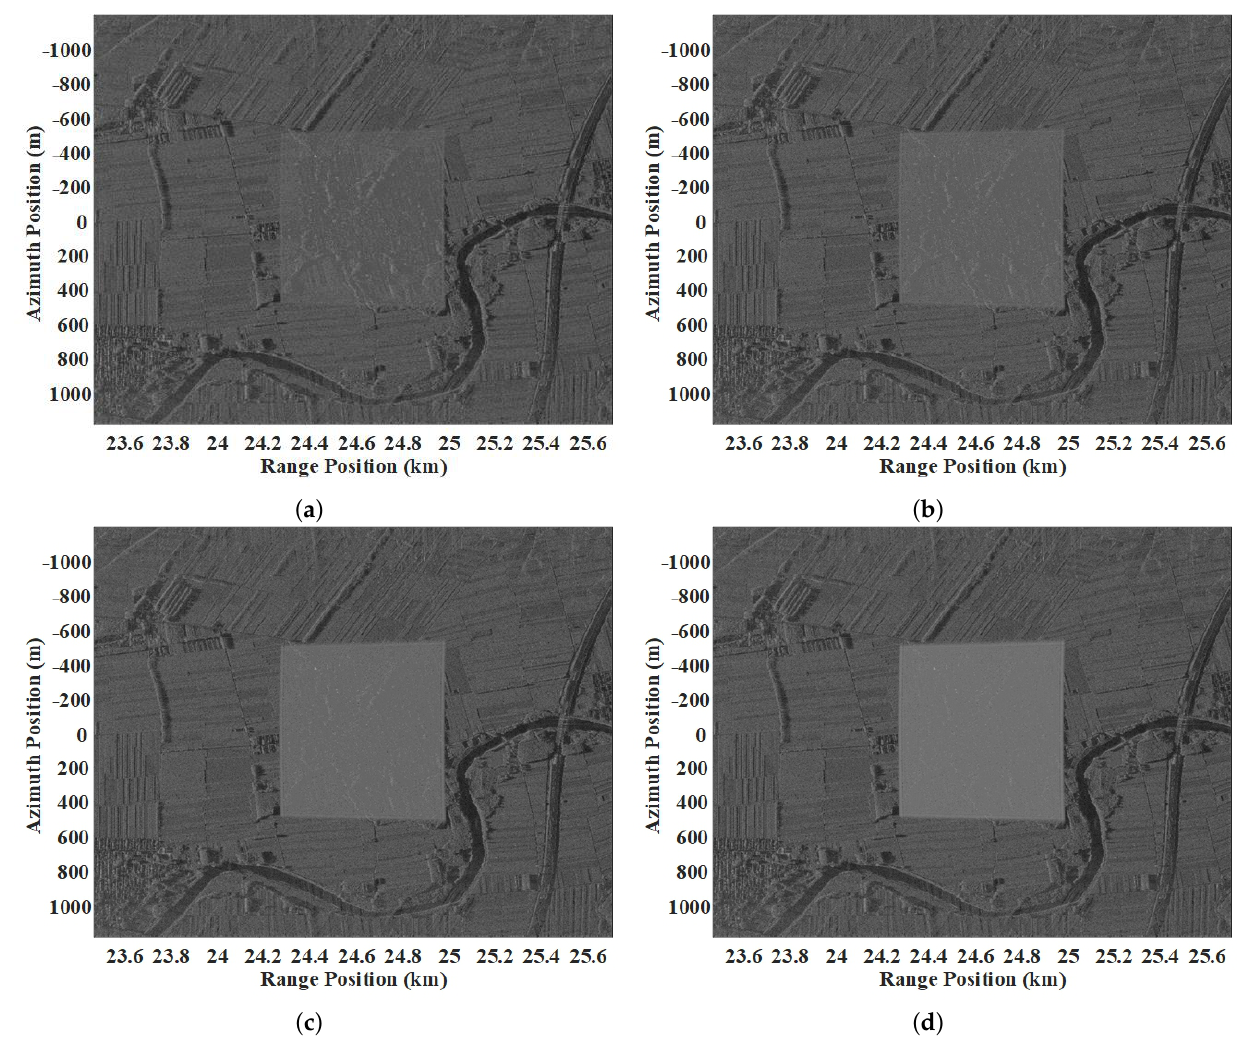
Figure 6. Imaging results of jamming data under different jamming to signal ratios. ( a ) JSR is 0